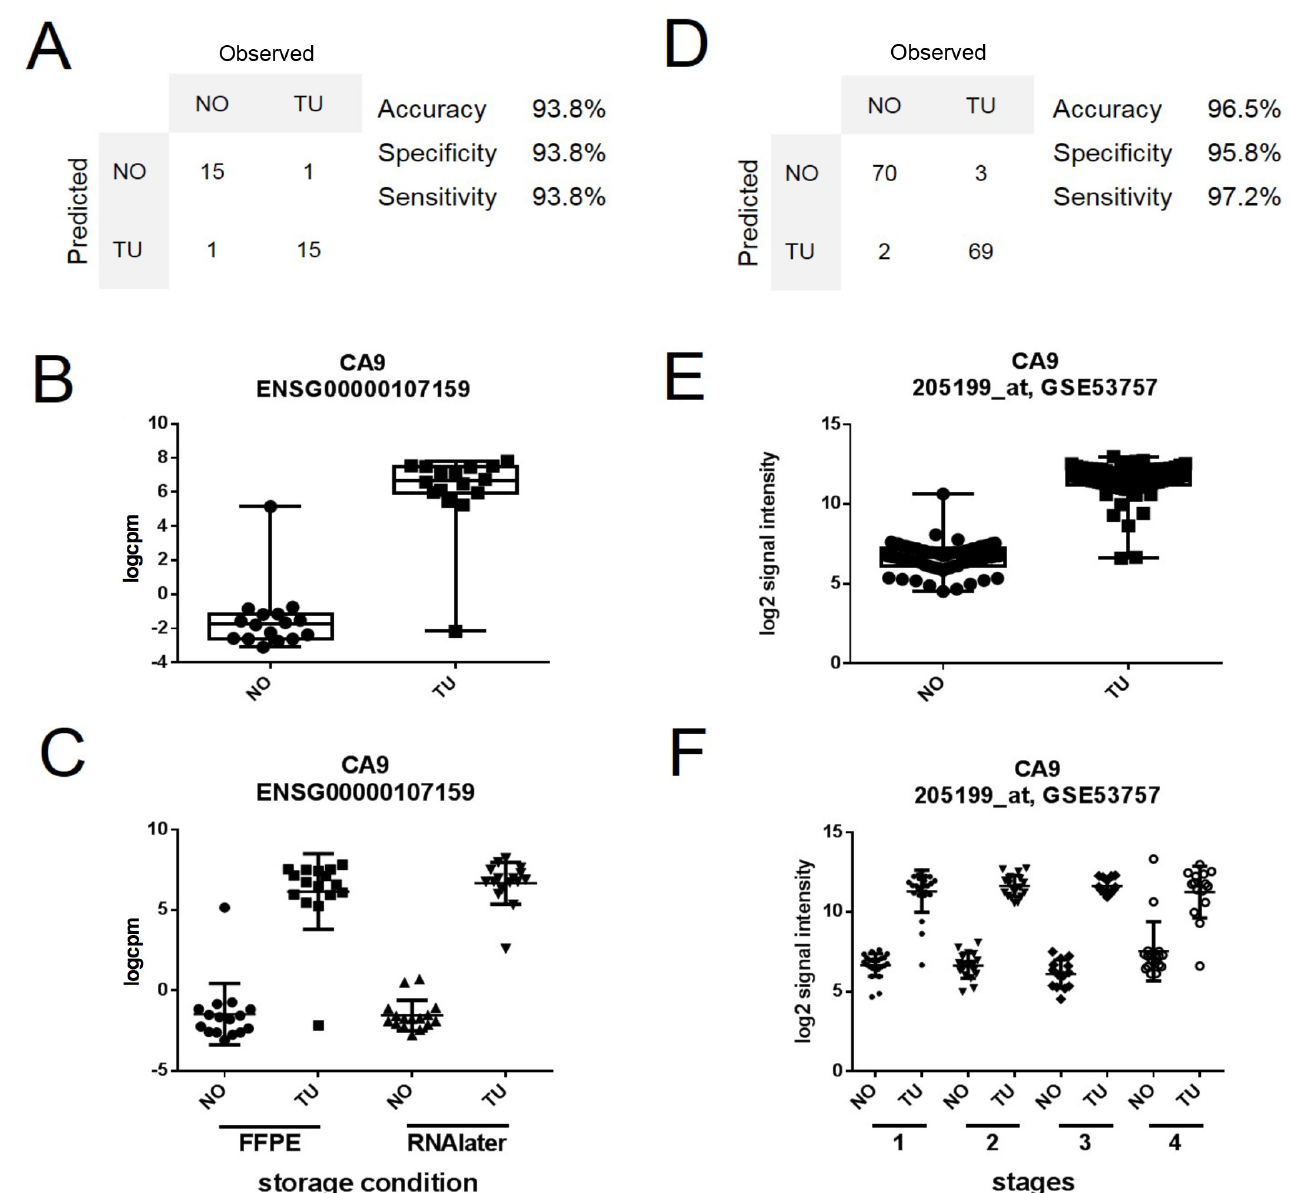
Fig 6. Development of a candidate marker for ccRCC. (A) Expression values of CA9 correctly classified 30 of 32 samples in our FFPE dataset. (B) Whisker plot of expression value distribution in our FFPE dataset for CA9 . (C) Scatterplot for the expression values of CA9 in our FFPE and in our RNAlater dataset. (D) CA9 expression values correctly classify 139 out of 144 samples in a microarray dataset of ccRCC (GSE53757). (E) Distribution of CA9 expression values for normal (NO) and ccRCC tumor samples (TU) in the GSE53757 dataset. (F) Stratification of the expression values of overexpressed CA9 into all four stages of ccRCC